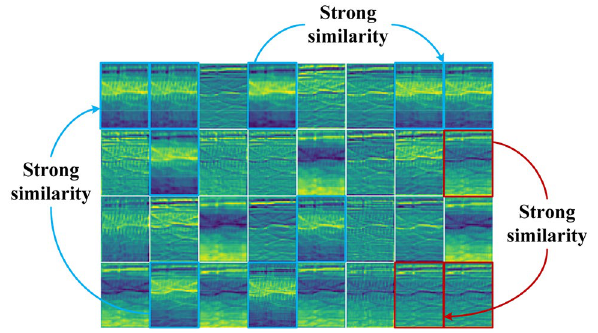
Figure 2. Display of feature maps for hidden middle layer output. (Heat maps are drawn by the plotting library Matplotlib 3.1.1. Detailed descriptions are available at https:// matpl otlib.